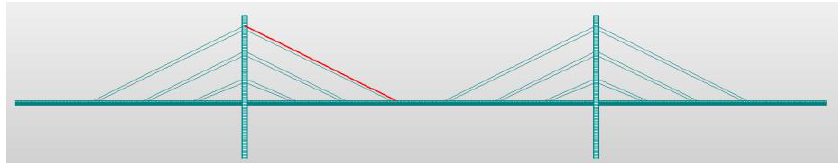
Figure 9. The diagram of the position of the 1133 diagonal cable.